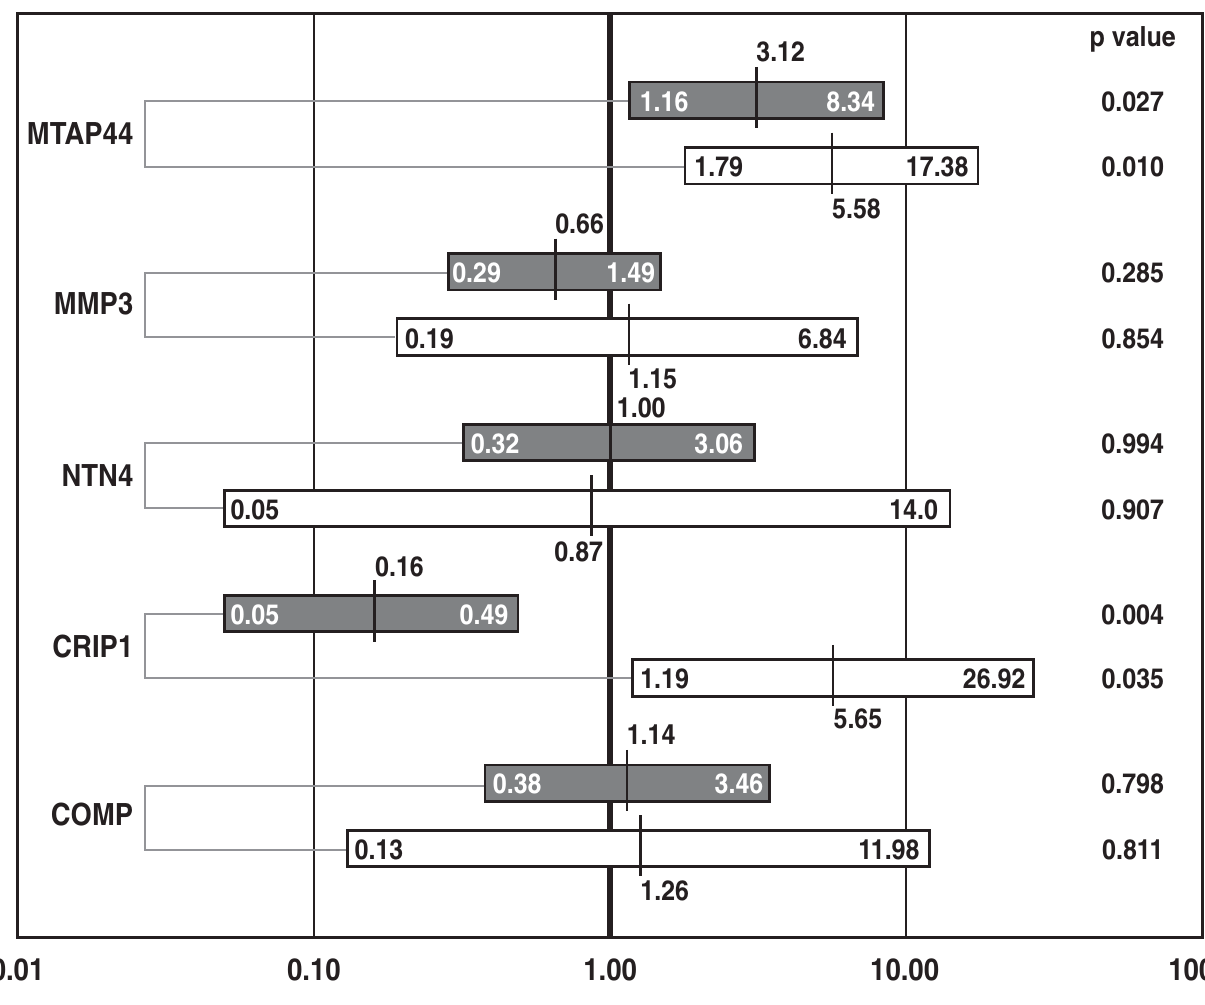
Figure 5 Ranges of fold changes, determined by quantitative RT-PCR for five genes, in multiple clonal cell strains from two Rett individ- uals (Statistical analysis of the data shown in Fig. 4). Dark bars represent comparisons of 7 wild-type and 7 mutant MeCP2 expressing clones from the 1155del32 mutation carrier. Open bars represent comparisons of 4 wild-type and 4 mutant MeCP2 expressing clones from the R106W mutation carrier. The lengths of the bars indicate the 95% confidence interval of the fold change in the log scale. The average estimated fold changes are identified by vertical lines (1.0 represents no change). P values are unpaired for the difference between the wild-type and mutant clones. Numbers at the bottom indicate log scale.